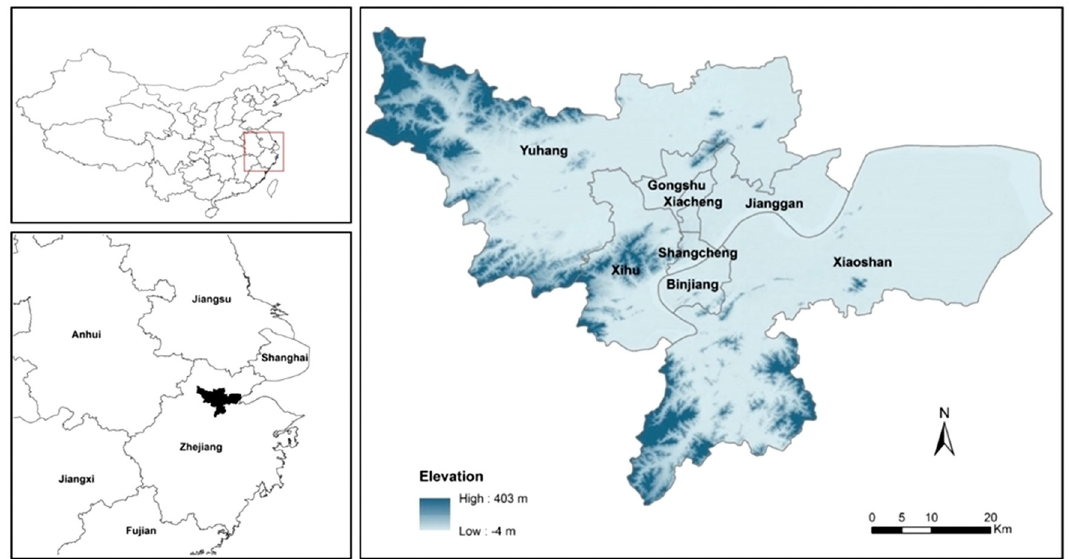
Figure 1. Location of study area (Hangzhou) and its